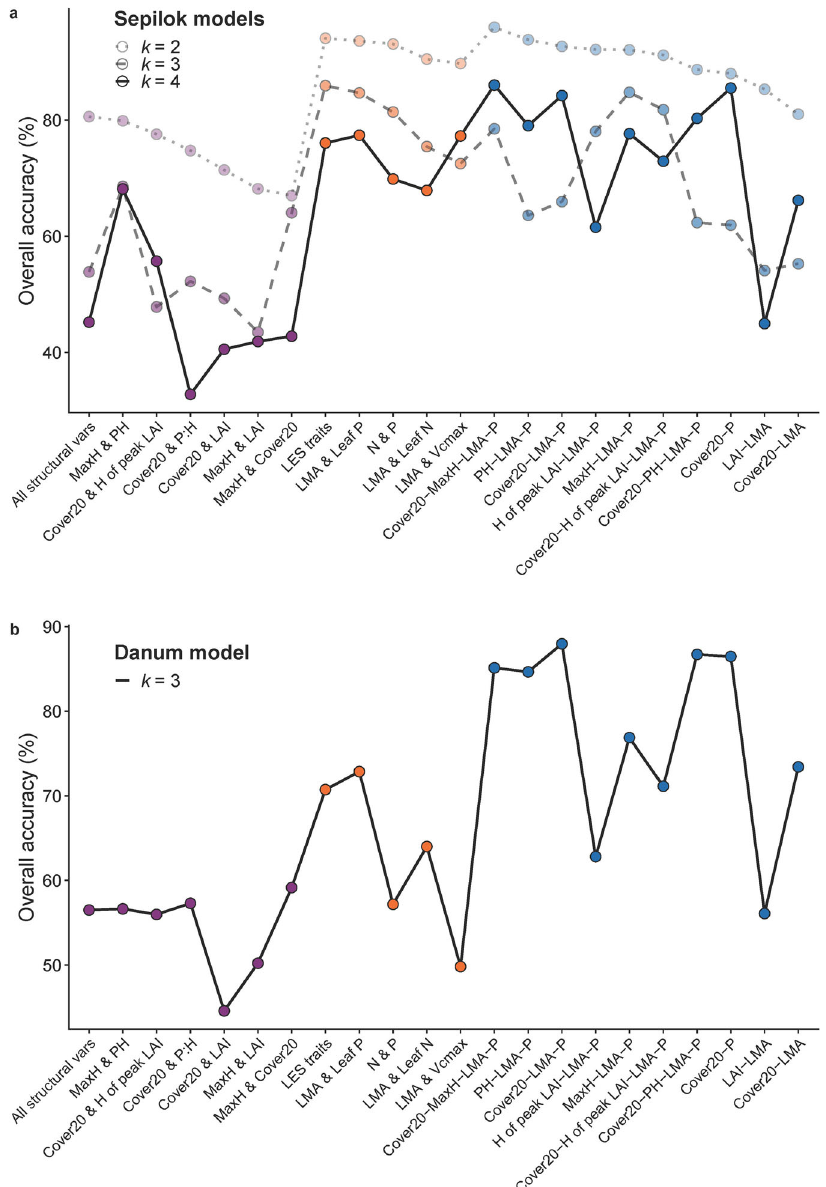
Fig. 5 Trait importance in forest type mapping. Change in overall accuracy for reduced k -means clustering models using forest structure variables (purple), canopy leaf trait variables (orange), and combinations of structural and leaf trait variables (blue) for k = 2, 3, and 4 for Sepilok and k = 3 for Danum. All results are compared to the full 10-variable k -means clustering analysis for Sepilok ( a ) and Danum ( b ). LES traits: leaf economic spectrum traits which include leaf mass per area (LMA), foliar nitrogen (N) and foliar phosphorus